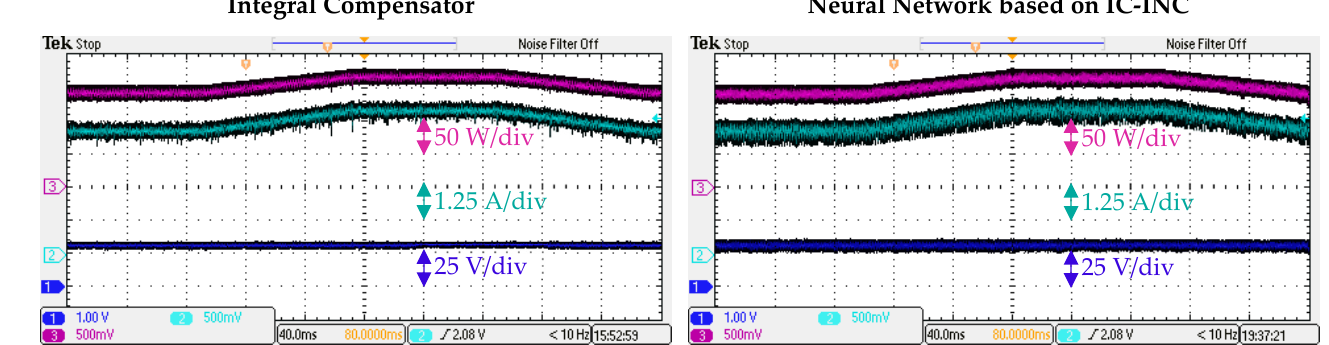
Figure 18. HIL results of power produced from panel when slow variations occurred. Table 3. Simulation results of MPPT efficiency.